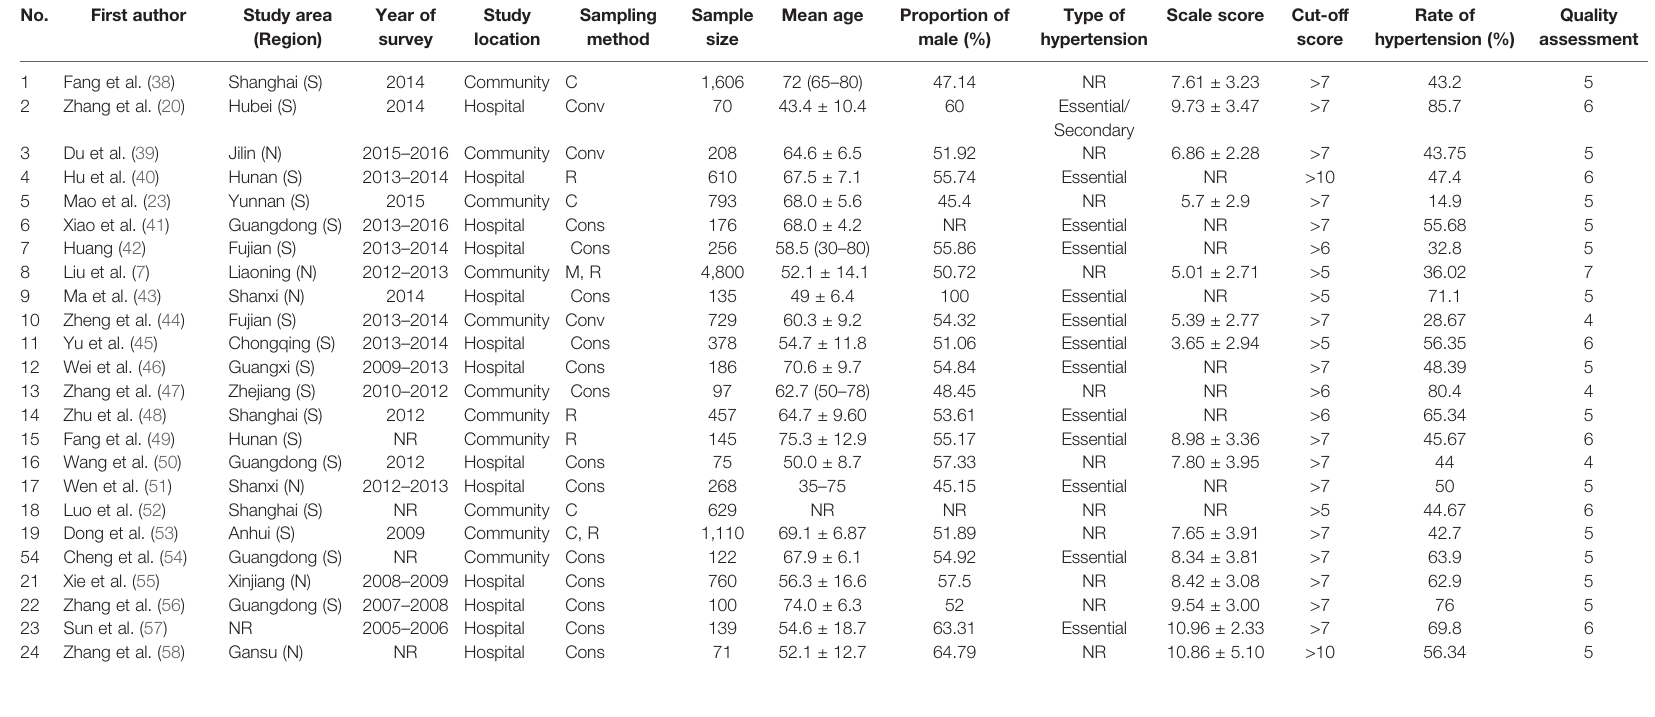
TABLE 1 | Characteristics of the studies included in the